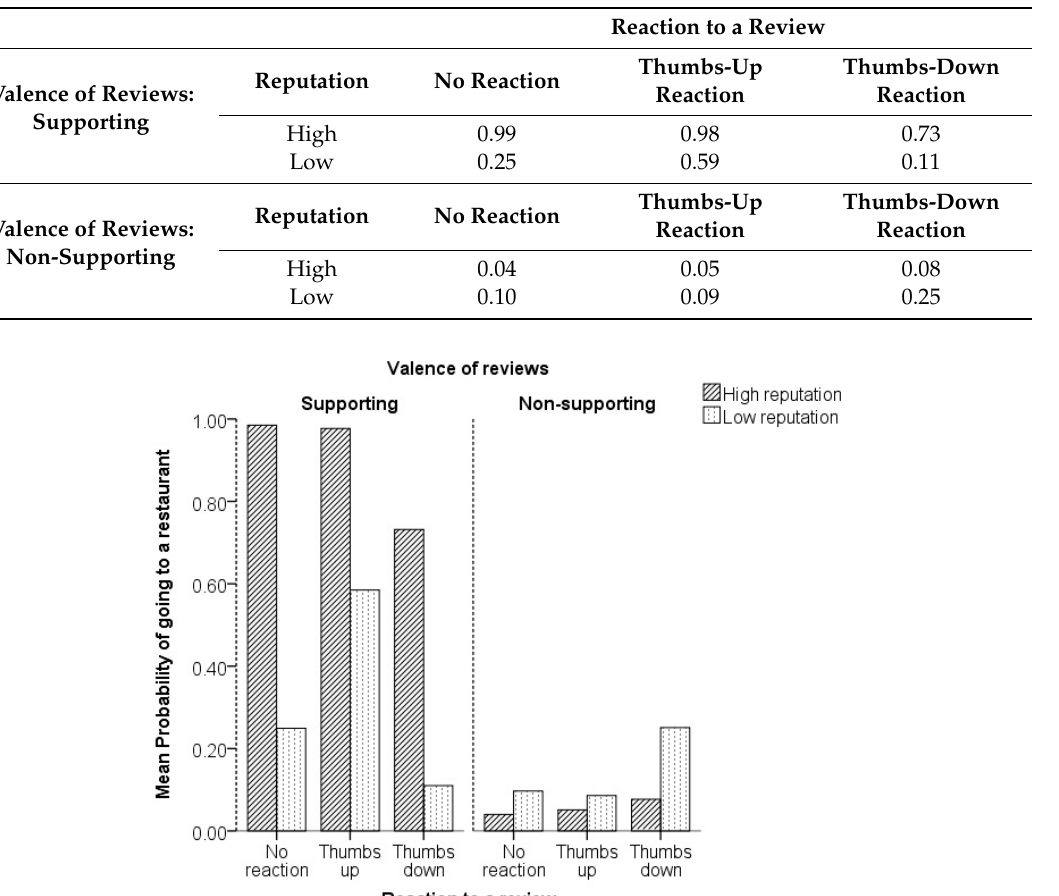
Table 4. Mean probability of going to the restaurant.